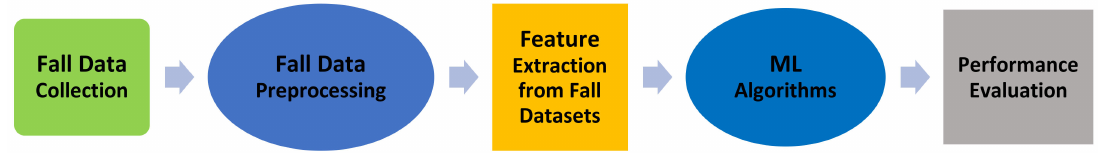
Figure 2. Fall detection overall procedure system using machine learning (ML)